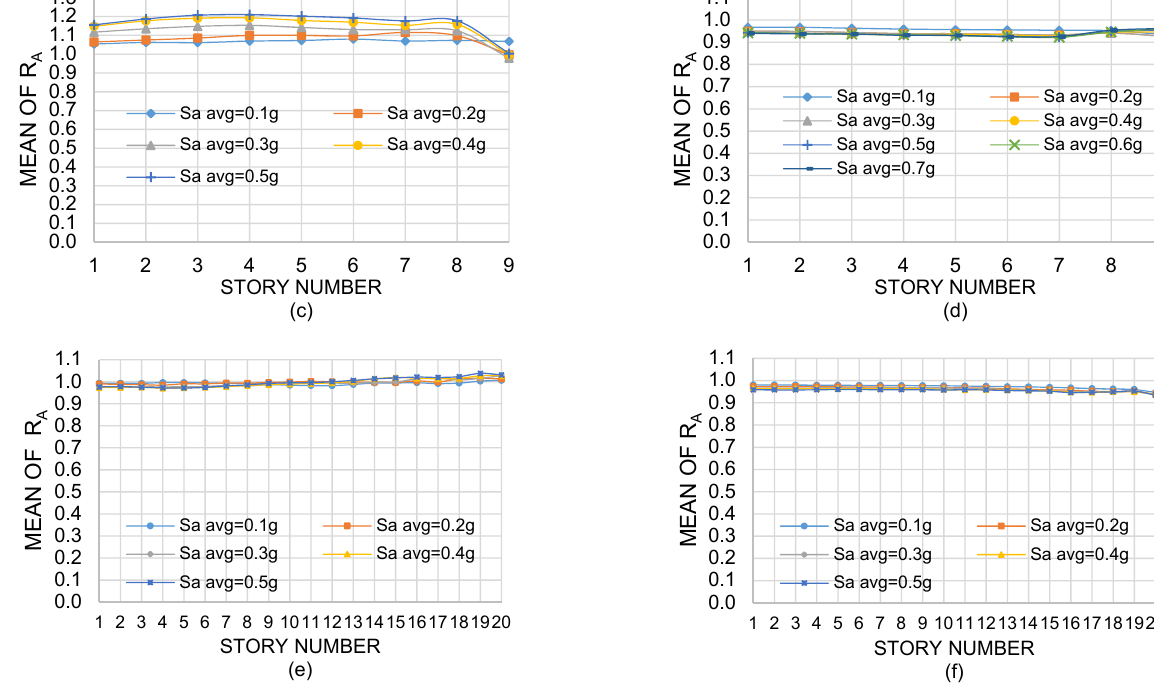
Figure 8. Mean values of R A , NS : ( a , c , e ), exterior columns of Models 1-2-3, respectively; ( b , d , f ), interior columns of Models 1-2-3, respectively.